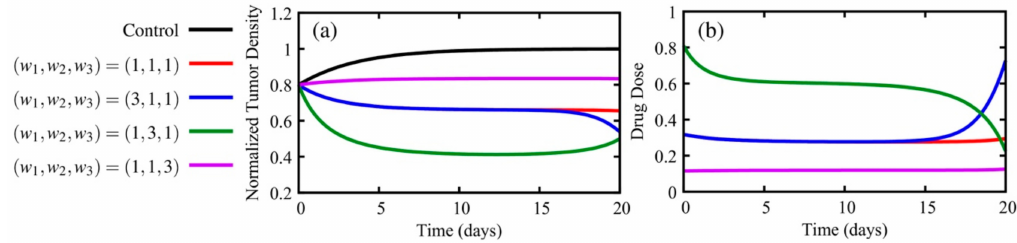
weight on the tumor density at the final time ( w 1 , w 2 , w 3 ) = (3,1,1) (blue), increased weight on the tumor density over the whole treatment ( w 1 , w 2 , w 3 ) = (1, 3, 1) (green), and increased weight on the therapy toxicity ( w 1 , w 2 , w 3 ) = (1, 1, 3) (purple). By varying the weights in the optimal control functional,